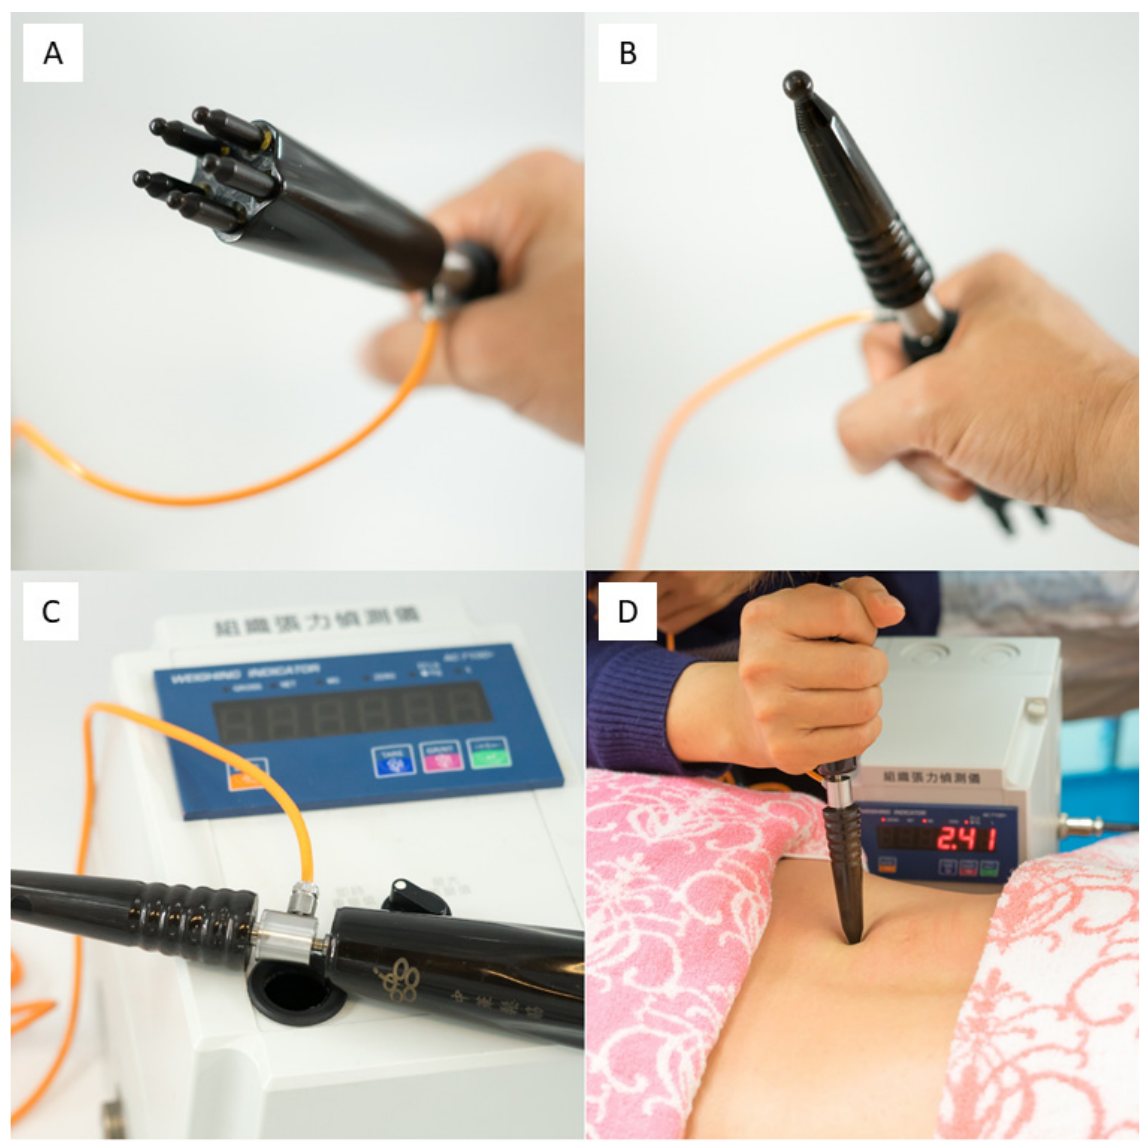
Figure 1. Photographs of the Massage Instrument. ( A ) The large end. ( B ) The small end. ( C ) The force sensor inserted into the middle of the instrument. ( D ) The therapist applied force perpendicularly to participants’ backs, and the monitor displayed the value of the applied force.